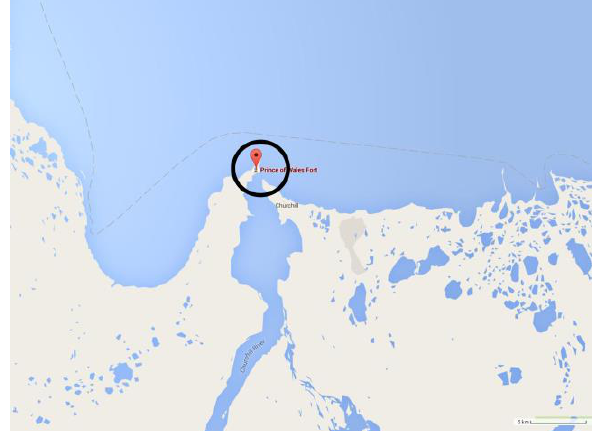
Figure 7: Location of Prince of Wales Fort (“Google Maps”